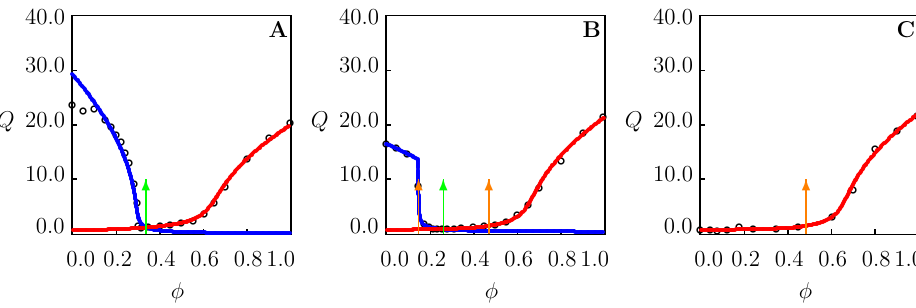
Figure 2. Equilibrium degree of swelling Q versus volume fraction of methanol φ in water/methanol mixture. Circles: experimental data [25] on PNIPAAm gel at temperatures T = 14.4 ( A ), T = 26.1 ( B ) and T = 35.3 ◦ C ( C ) . Solid lines: results of numerical analysis. Arrows indicate the phase transition